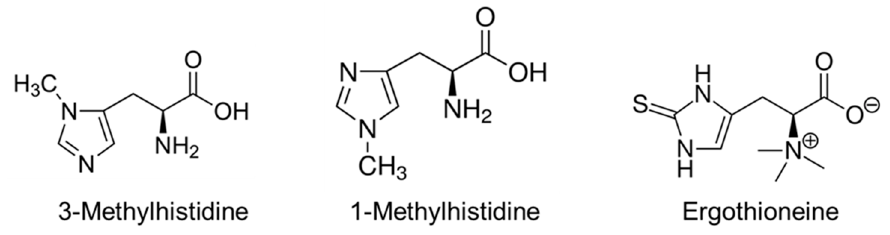
Figure 5. Methyl- and sulphur-containing derivatives of HIS.